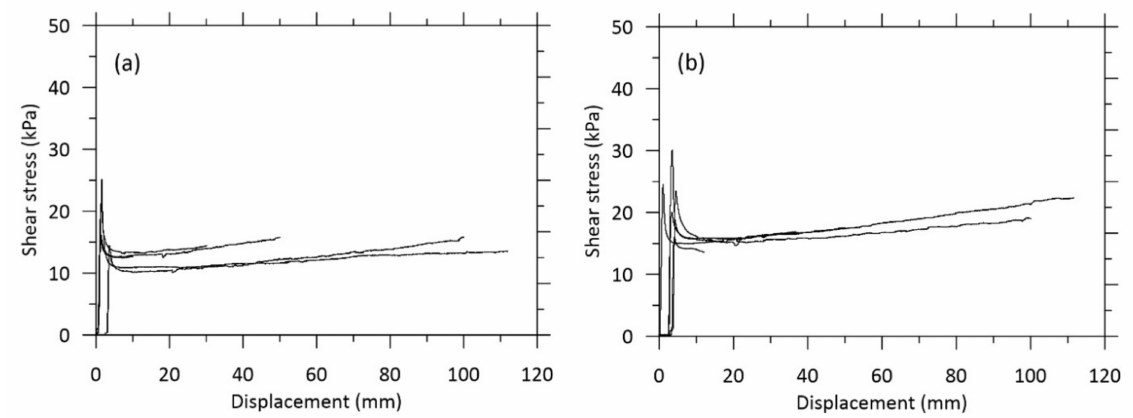
Figure 4. Shear stress and displacement as a function of rotation at 10, 30, 50, 100, and 110 mm. Shear characteristics and determination of residual shear stress with shear displacement for ( a ) drained and ( b ) undrained